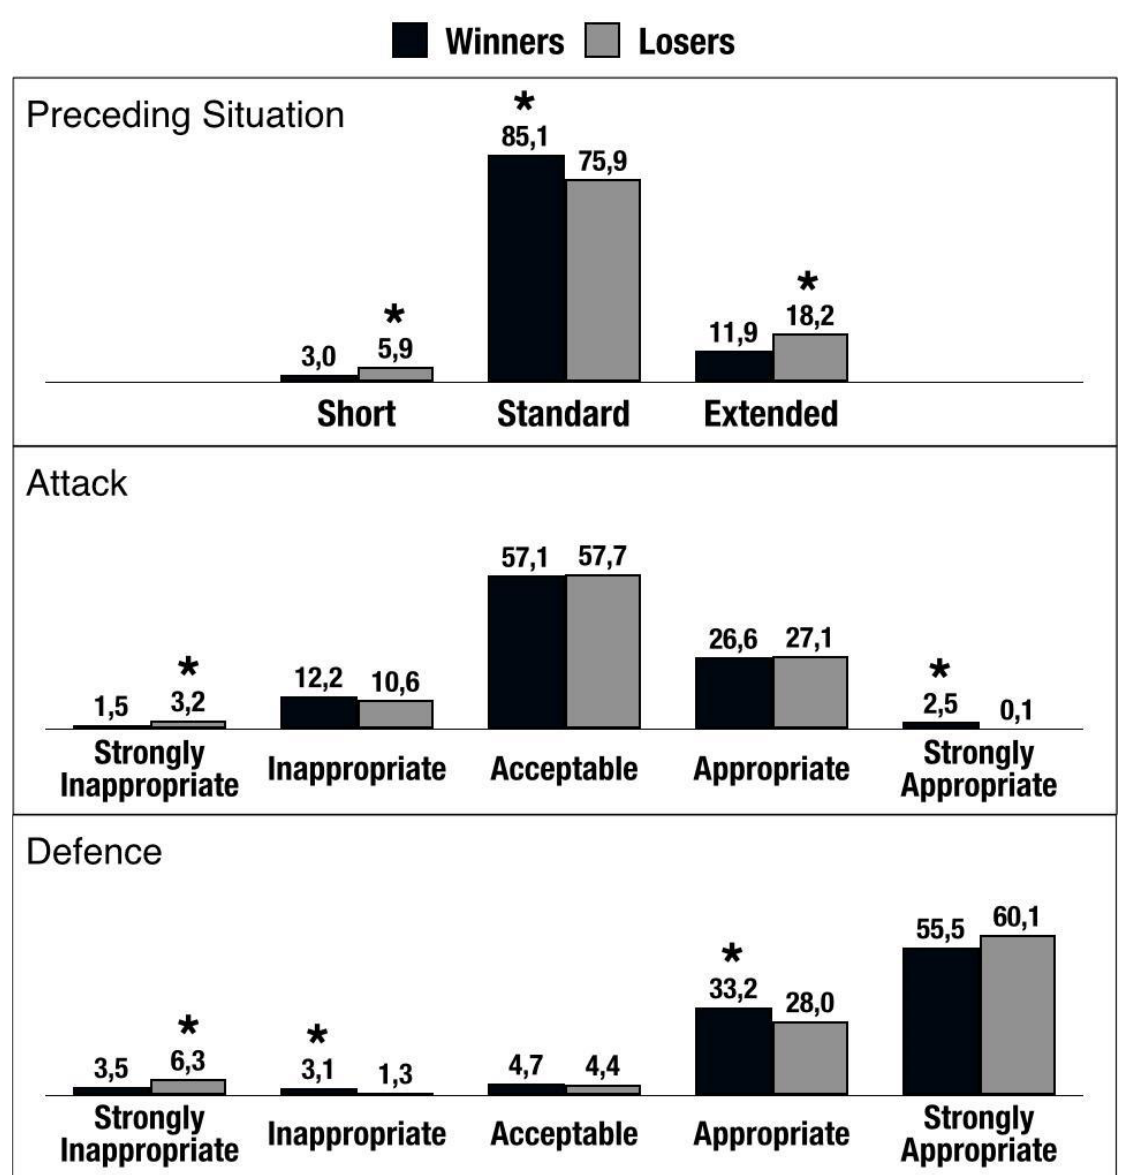
Figure 3 . Mean percentage of relative quality in match outcome comparison between winners vs. losers teams. Note: * p <